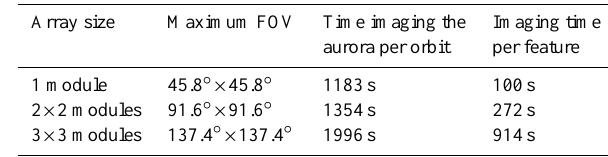
Table 6. Maximum imaging time per feature as a result for three modular configurations. R MCP =100mm for all optical elements, assuming a circular orbit at an altitude of 800km, and an auroral altitude of